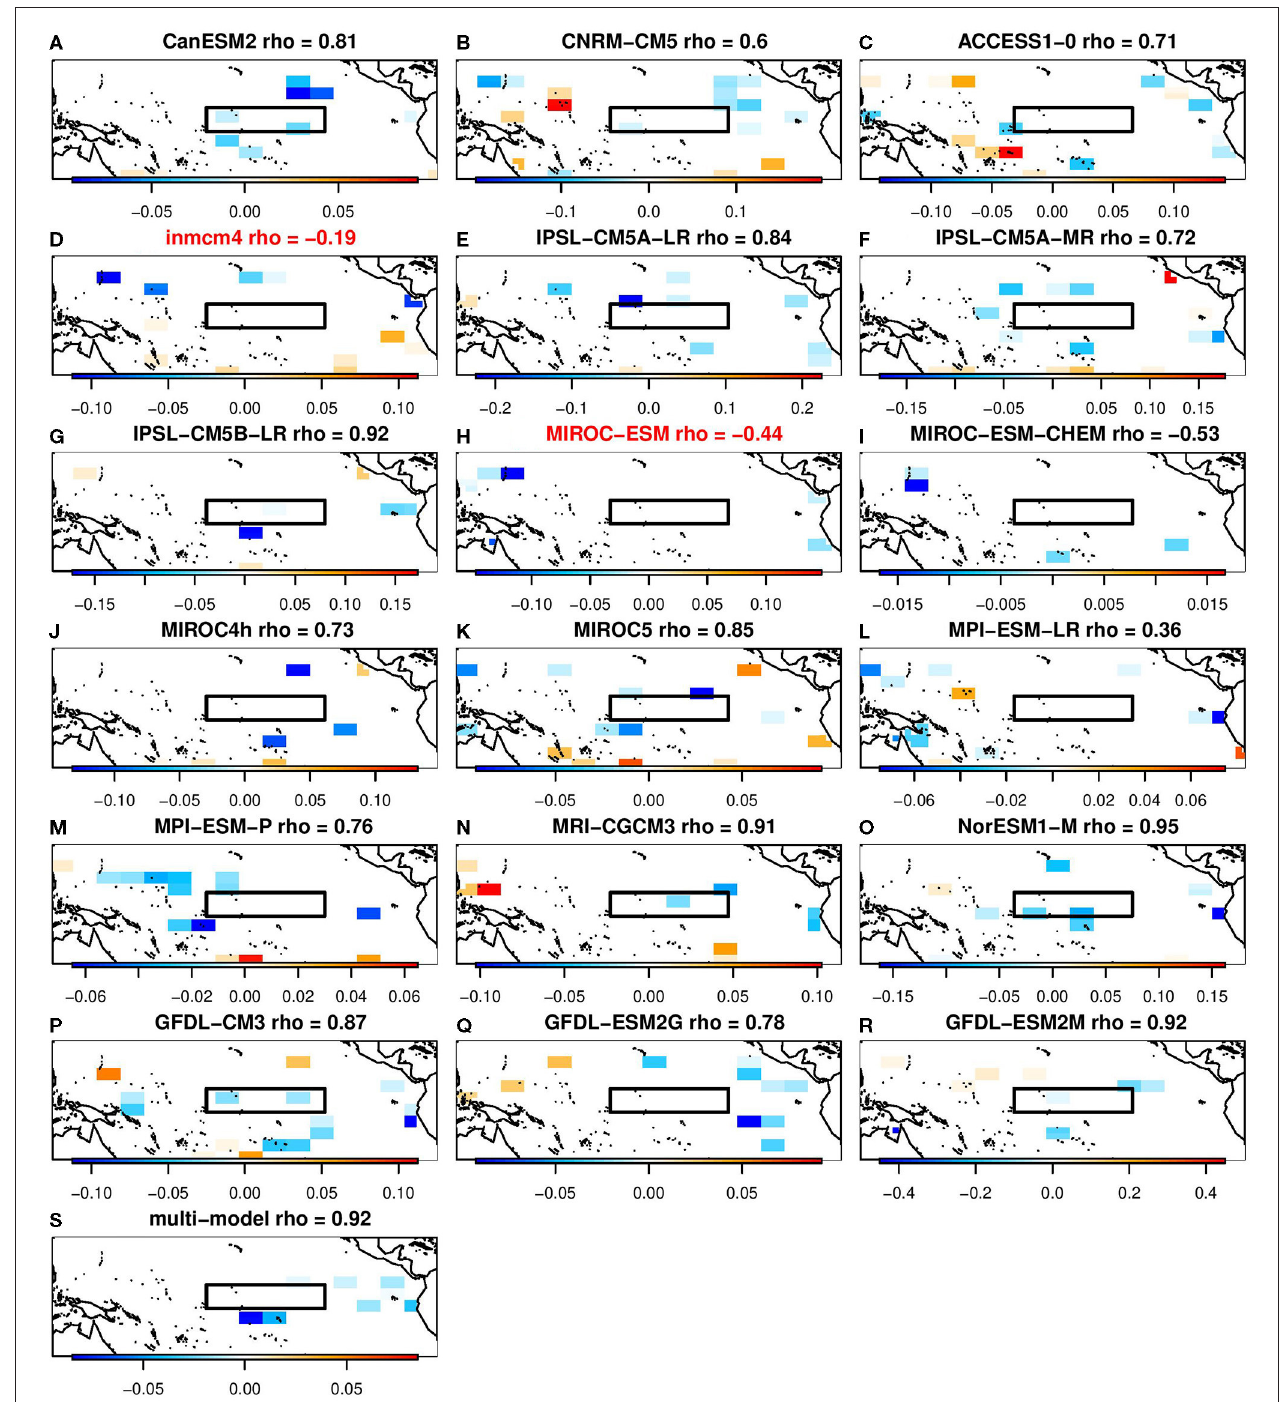
FIGURE 5 | The β coefficients selected by lasso for predicting week 3–4 ENSO-forced temperature pattern using grid points in the Tropical Pacific. The black boxes indicates the Nino3.4 index. Red model names indicate the models that individually had a minimum NMSE greater than 1. (A) CanESM2 rho= 0.81. (B) CNRM-CM5 rho = 0.6. (C) ACCESS1-0 rho = 0.71. (D) inmcm4 rho = − 0.19. (E) IPSL-CM5A-LR rho = 0.84. (F) IPSL-CM5A-MR rho = 0.72. (G) IPSL-CM5B-LR rho =0.92. (H) MIROC-ESM rho = − 0.44. (I) MIROC-ESM-CHEM rho = − 0.53. (J) MIROC4h rho = 0.73. (K) MIROC5 rho = 0.85. (L) MPI-ESM-LR rho = 0.36. (M) MPI-ESM-P rho = 0.76. (N) MRI-CGCM3 rho = 0.91. (O) NorESM1-M rho = 0.95. (P) GFDL-CM3 rho = 0.87. (Q) GFDL-ESM2G rho = 0.78. (R) GFDL-ESM2M rho = 0.92. (S) Multi-model rho = 0.92.